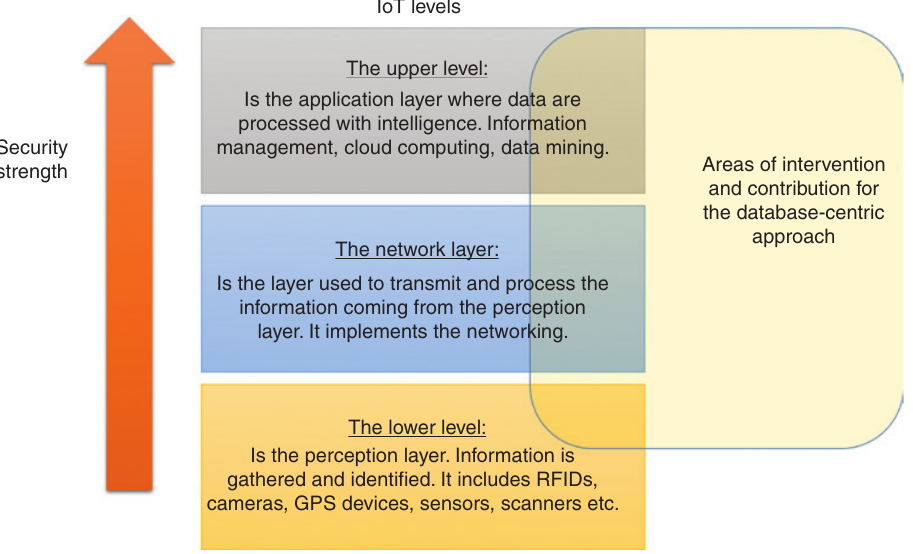
Figure 9: Area of Intervention of the Database-Centric Approach for